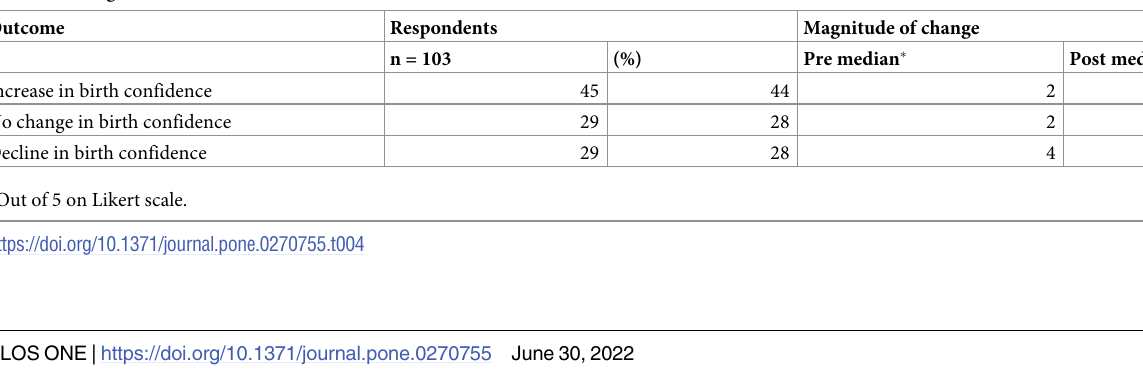
Table 4. Change in birth confidence